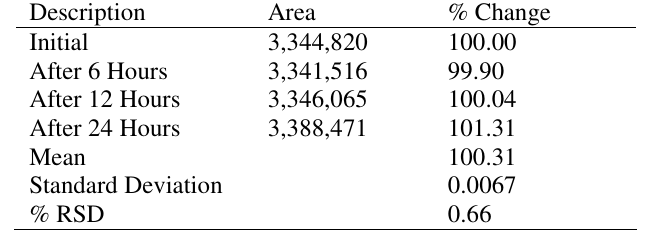
Table 5. Stability Data for